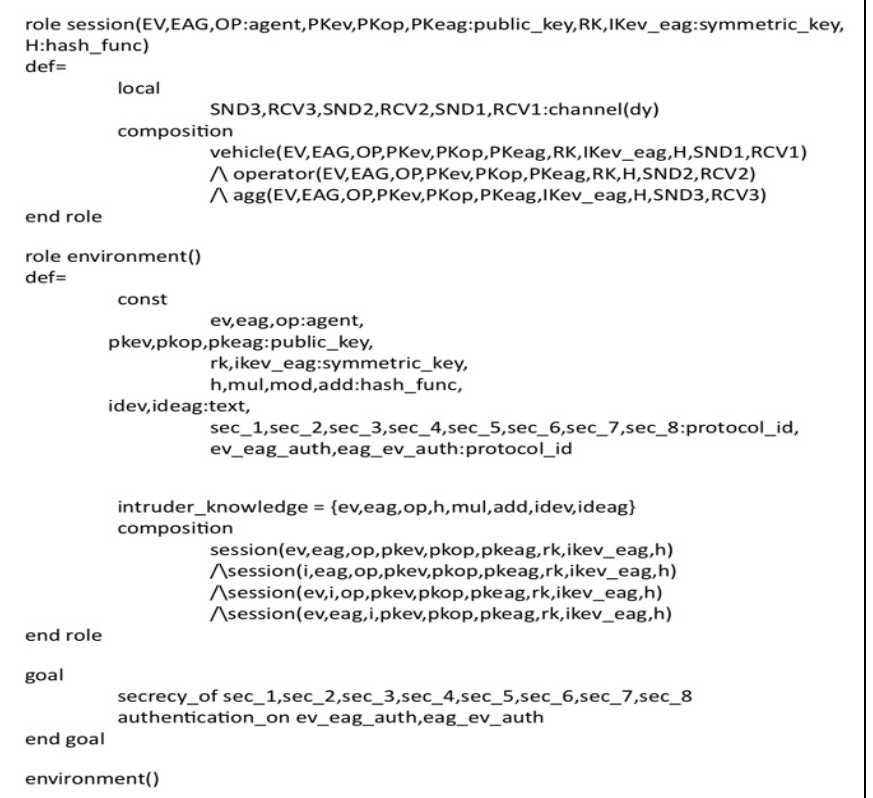
Figure 11. Mutual Authentication Specification of the session and environment.